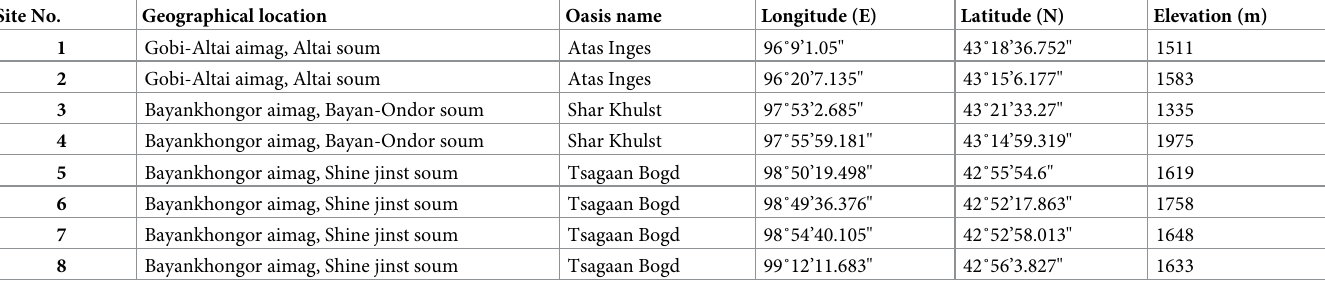
Table 1. Geographical information of sampling sites in Great Gobi “A” Strictly Protected Area. Site